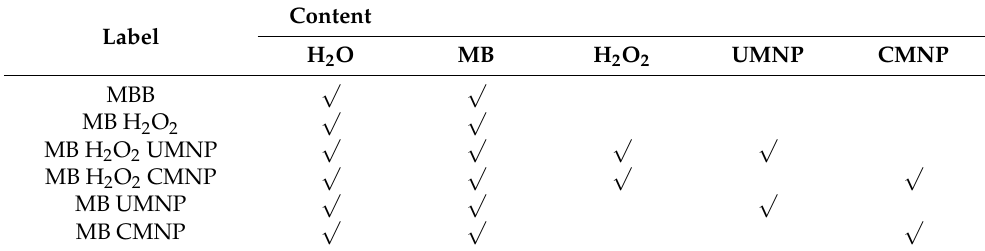
Table 1. Composition of the six labeled samples prepared to degrade the MB.